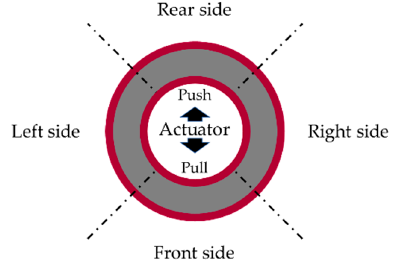
Figure 22. Definition of specimen direction.